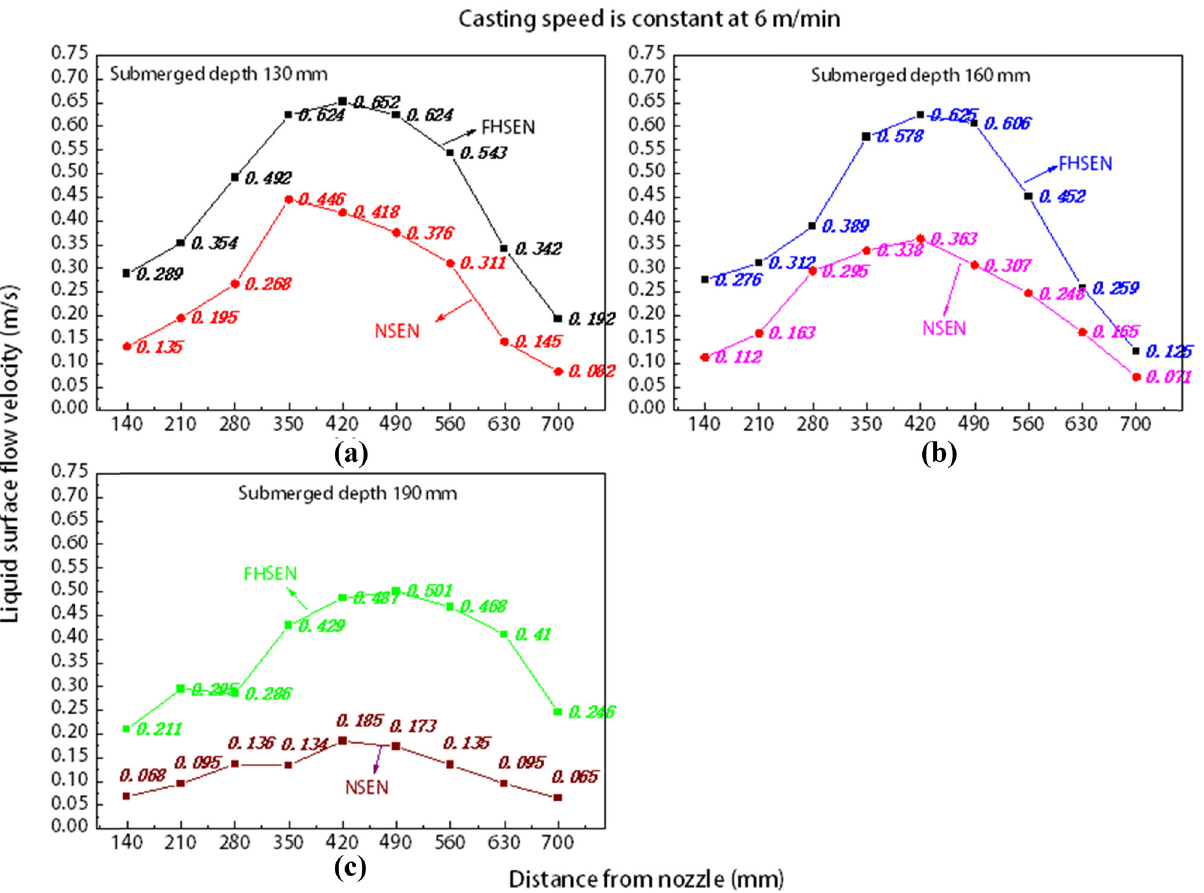
Figure 20: Time - averaged surface velocity by the nail board measurements at a casting speed of 6 m · min − 1 : ( a ) 130 mm, ( b ) 160 mm, ( c ) 190